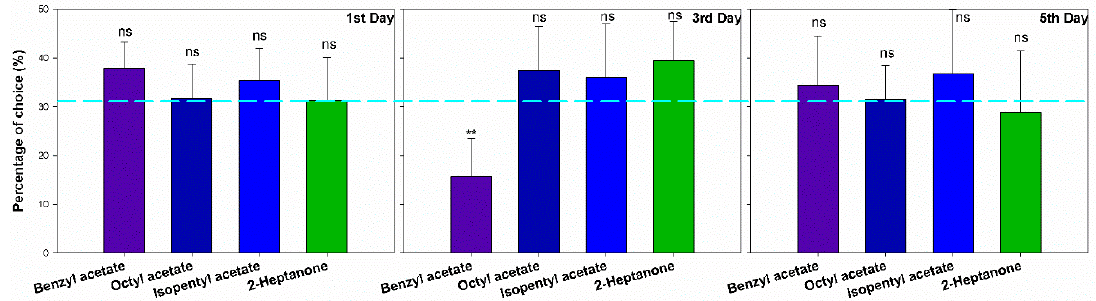
Figure 2. The choice of greater wax moths (1st day n = 60, 3rd day n = 60 and 5th day n = 60) to different bee alarm pheromones in the Y maze. The light-blue reference line showed 33.33%, error bars presented with Mean ± SEM. “ns” means no significant difference, “**” means significant difference ( p < 0.01).